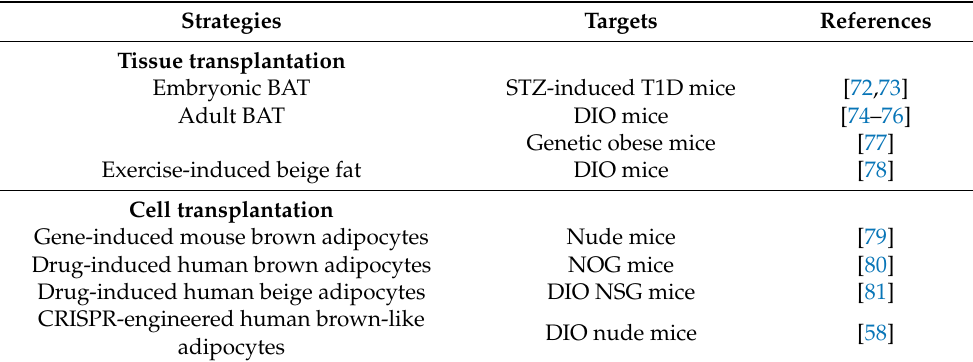
Table 3. Studies showing increase in thermogenic adipocytes using tissue and cell transplantation in obese